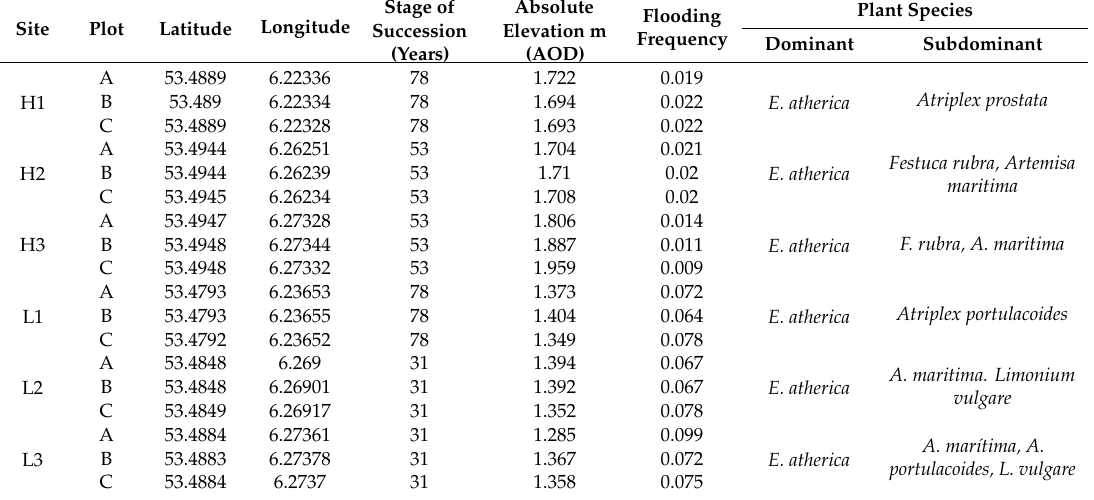
Table 1. Location and characteristics of the sample sites at the salt marsh of Schiermonnikoog, the is expressed in years after establishment. Flooding frequency is expressed as the annual proportion of inundated time. At each site the dominant and subdominant vegetation was